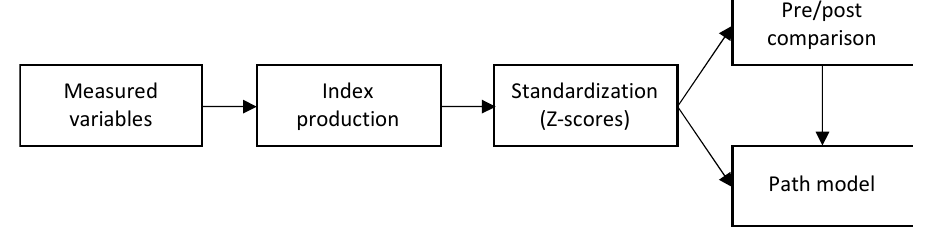
Figure 1. Methodological framework.